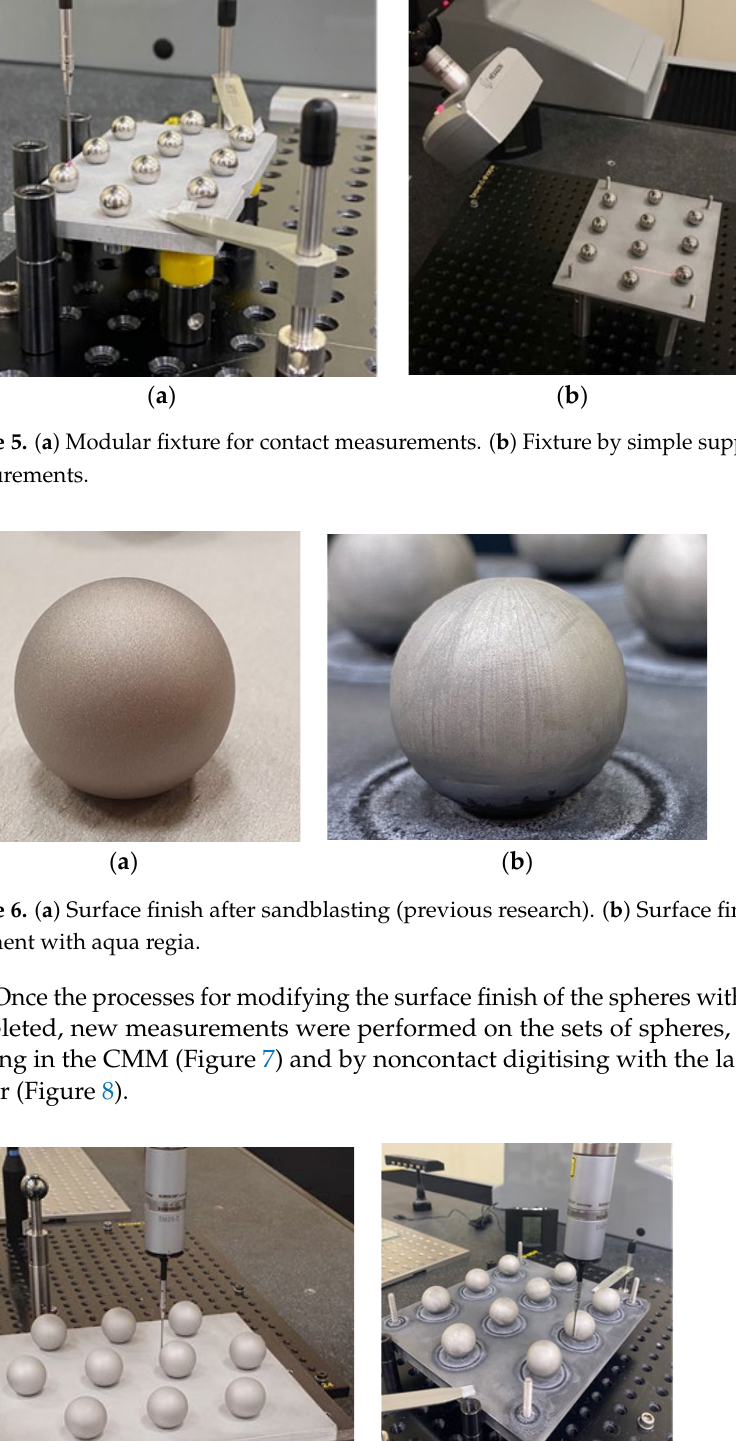
Figure 7. Contact measurements of sets of spheres after each treatment. ( a ) After sandblasting ( b ) After chemical etching.